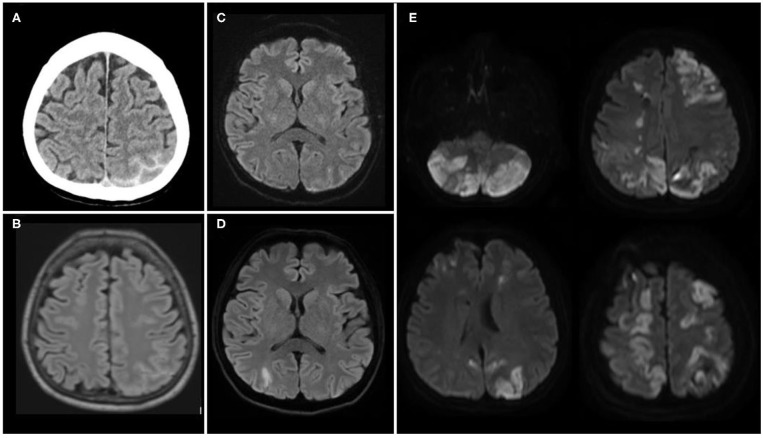
Illustration of radiological brain lesions over time. (A) Left convexity subarachnoid hemorrhage (SAH) on Day 4 (non-contrast CT). (B) Brain parenchyma without damage next to the left convexity SAH on Day 4 [MRI, T2 Fluid Attenuated Inversion Recovery (FLAIR)]. (C) Brain parenchyma without damage on Day 4 [MRI, Diffusion Weighted Imaging (DWI)]. (D) Right watershed infarct at the border zone between right middle and posterior cerebral arteries on Day 11 at the time of first neurological deterioration (MRI, DWI). (E) Multiple hemodynamic strokes in supratentorial and infratentorial regions on Day 18 (MRI, DWI).